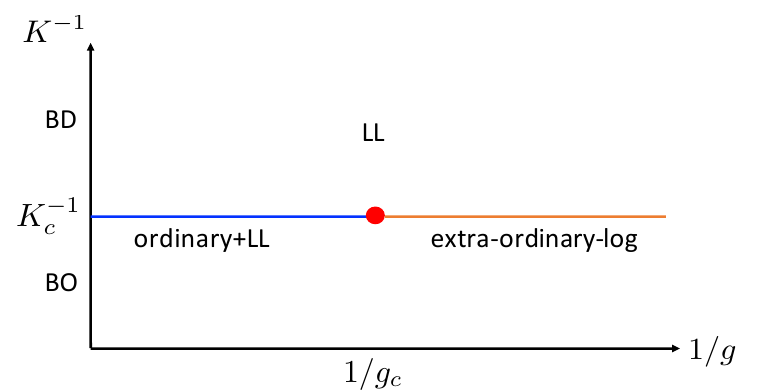
Figure 6: Conjectured phase diagram for the 2 + 1D Bose-Hubbard model with in- teger bulk filling and an incommensurate excess boson density ρ on the boundary. K is a non-thermal tuning parameter in the bulk and g is the tuning parameter on the boundary. LL stands for bulk-disordered and boundary being a Luttinger-liquid. Ordinary + LL stands for a boundary Luttinger liquid essentially decoupled from the bulk with an ordinary boundary condition. In the case of commensurate excess bo- son density ρ = p with ( p , q ) = 1 and q ≥ 3, the phase diagram is essentially the q same, except for the presence of an additional charge-density-wave boundary phase at large g